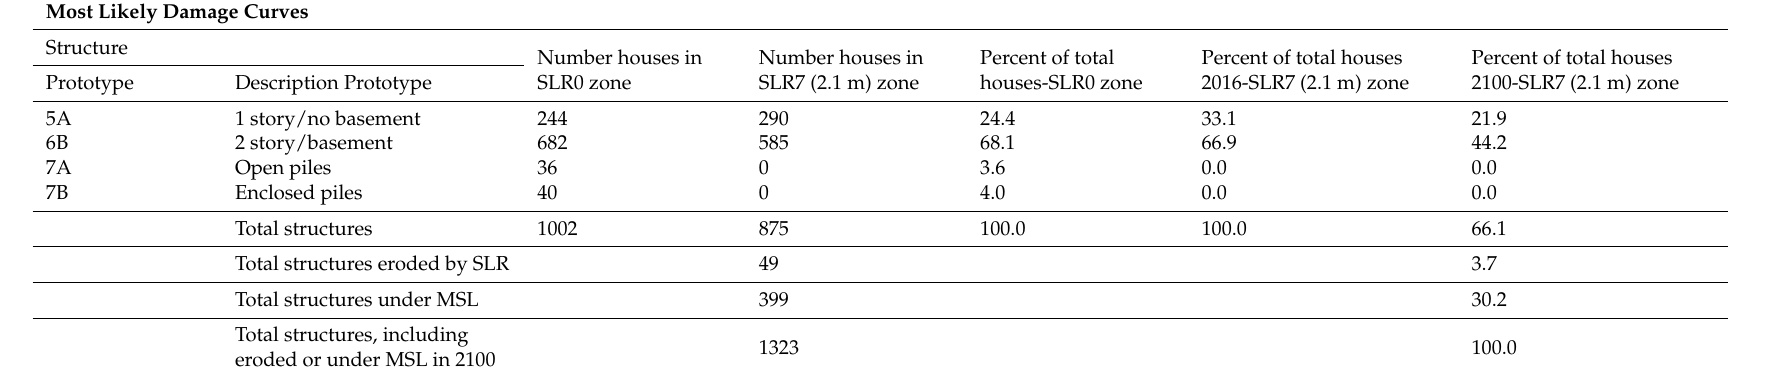
Table 2. Number of structures total and damaged for Charlestown, RI study area for various